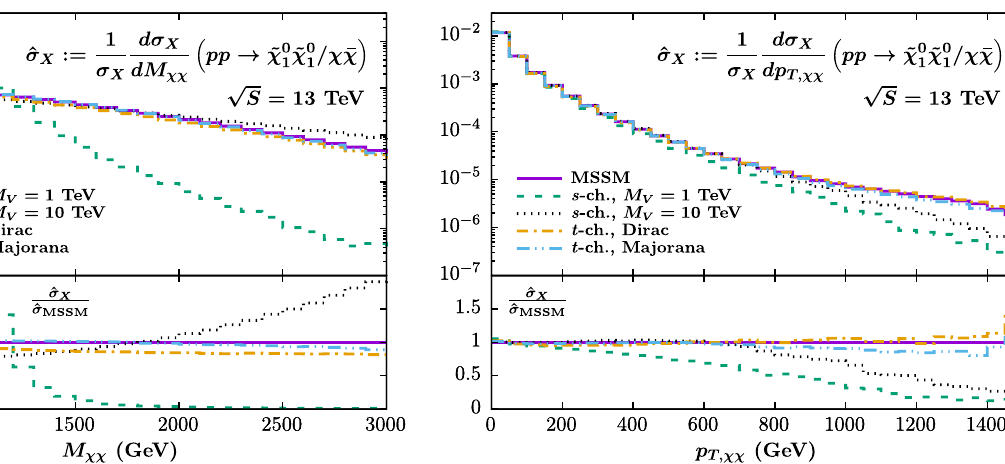
Fig. 9 Invariant mass (left) and transverse momentum distribution (right) of the DM pair system at NLO+PS accuracy. Masses and param- eters are chosen according to the ˜ w parameter point of Fig. 7. Shown are predictions for the MSSM (solid purple line), the s -channel model